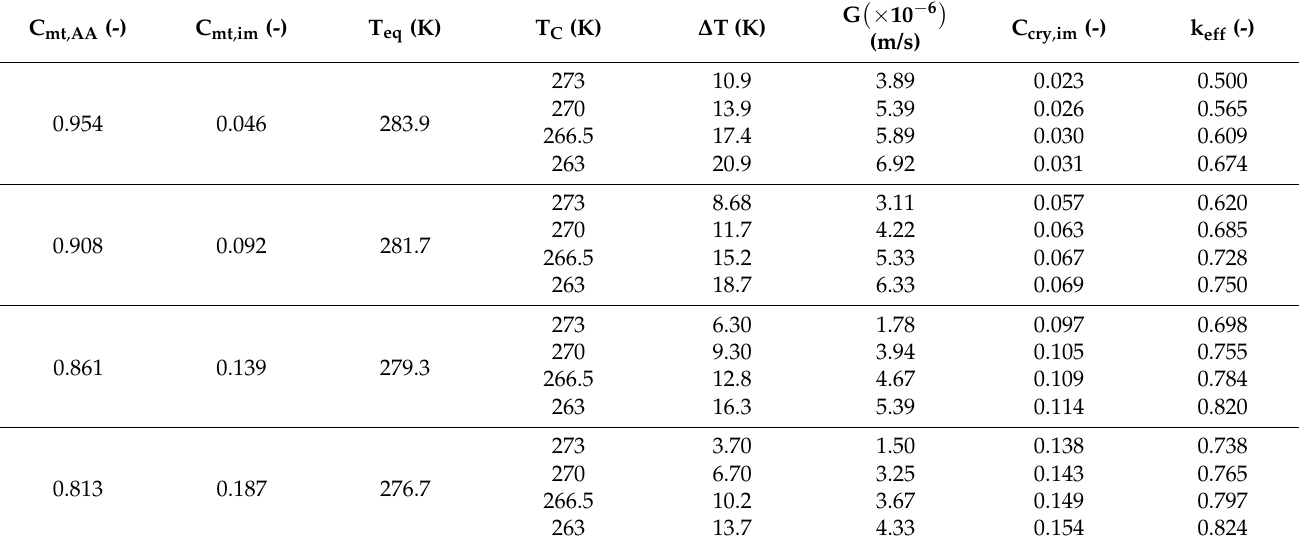
Table 1. The experimentally measured data of G and C cry,im for various C mt,AA operated at various T C from the binary AA/PA